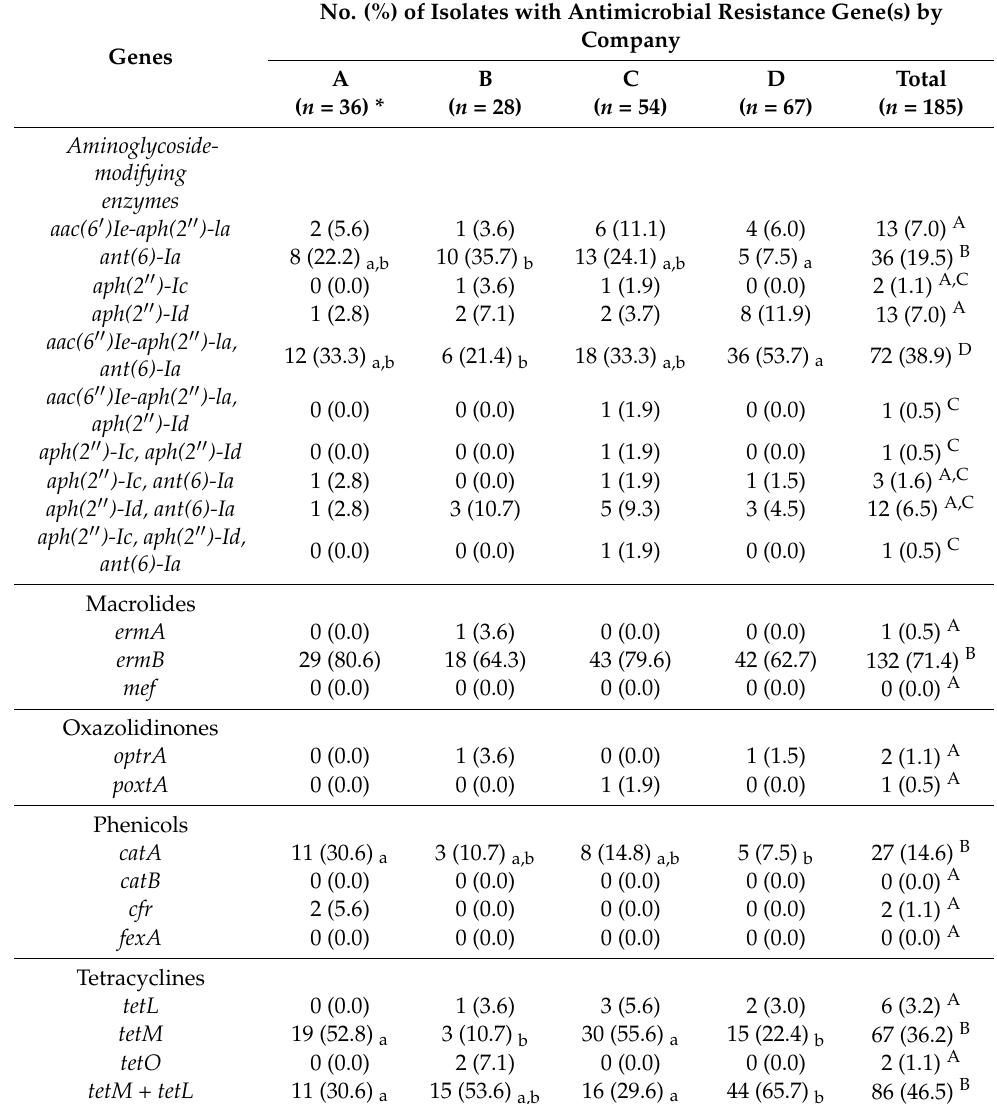
Table 4. Distribution of antimicrobial resistance genes of 185 high-level aminoglycoside-resistant Enterococcus faecalis from the bulk tank milk of four dairy companies. No. (%) of Isolates with Antimicrobial Resistance Gene(s) by Genes